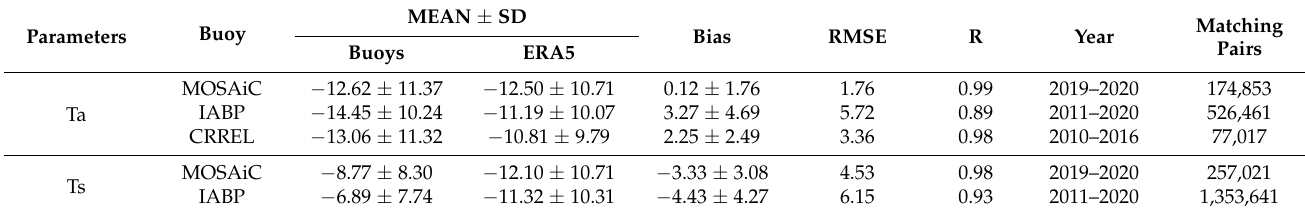
Table 7. Estimated biases for the Ta and Ts from the ERA5 for different buoy projects.